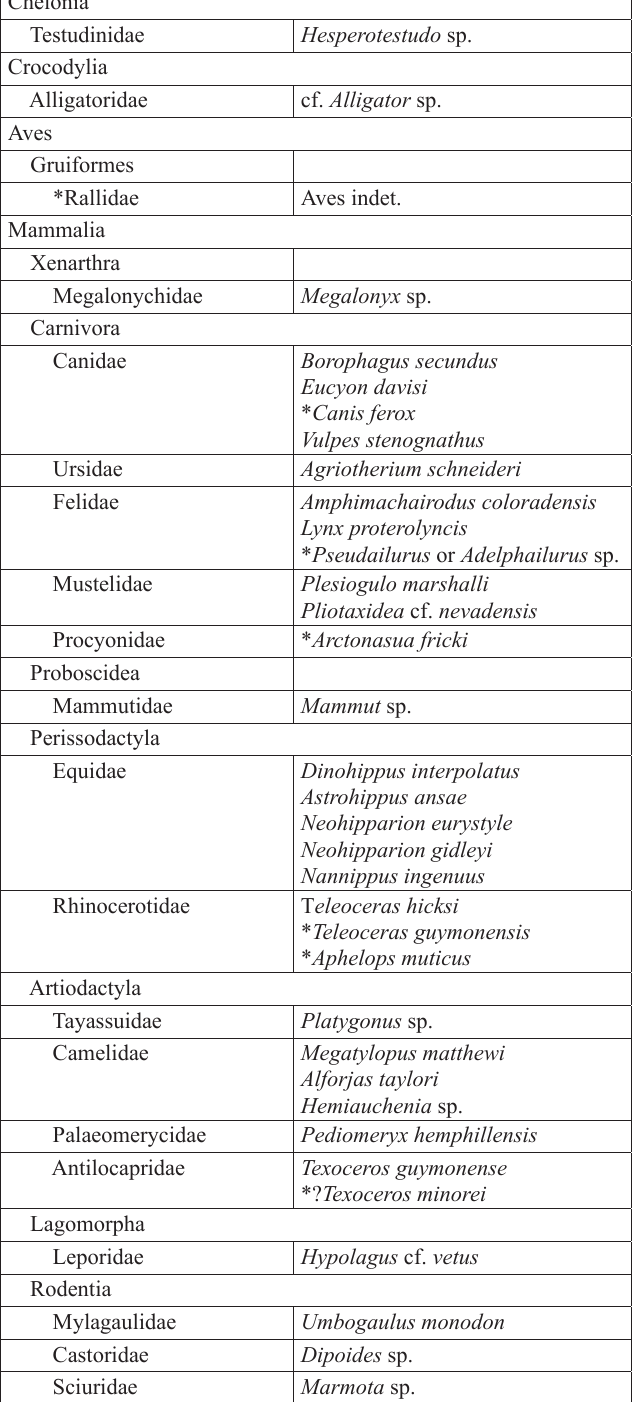
Table 1. Vertebrate taxa list for the Optima Local Fauna (Miocene, late Hemphillian, Oklahoma, USA), updated from Hesse (1936), Savage (1941), Hirschfeld and Webb (1968), Harrison (1979, 1981),